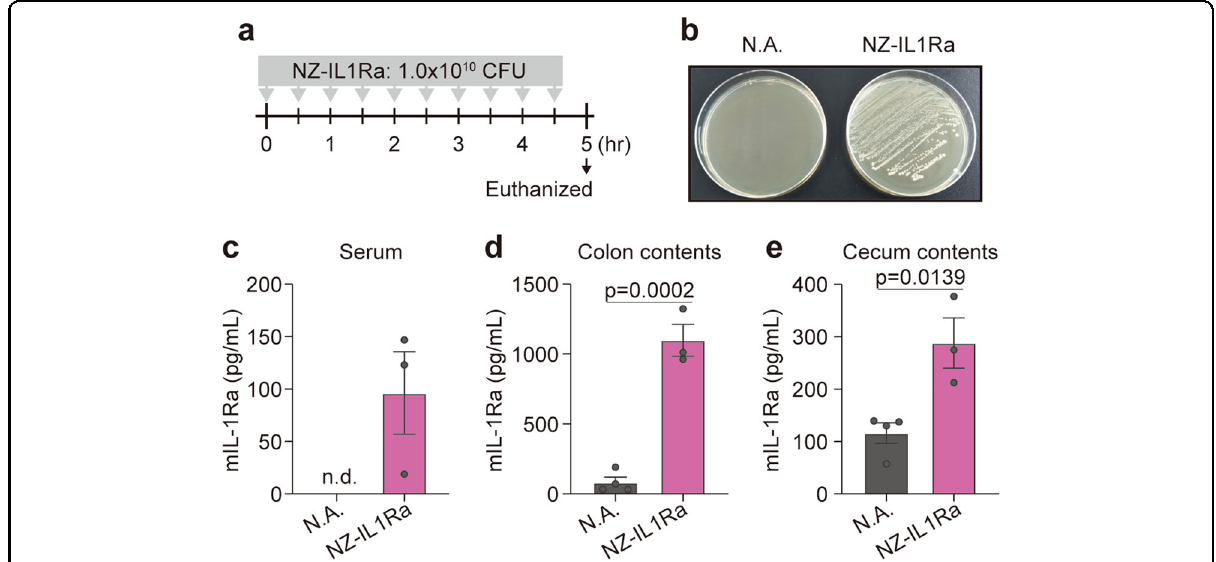
Fig. 4 Intestinal delivery of rmIL-Ra by oral administration of NZ-IL1Ra. a Schedule for oral administration of NZ-IL1Ra. b GM17cm agar plate streaked with colonic contents of the NZ-IL1Ra group or nonadministration group. c – e mIL-1Ra concentration in the serum, colonic contents, and cecal contents of each group. Data are the mean ± SE ( n = 3 – 4), and each dot in the plot represents one mouse. N.A. nonadministration group, NZ-IL1Ra NZ-IL1Ra administration group, n.d. not detected.